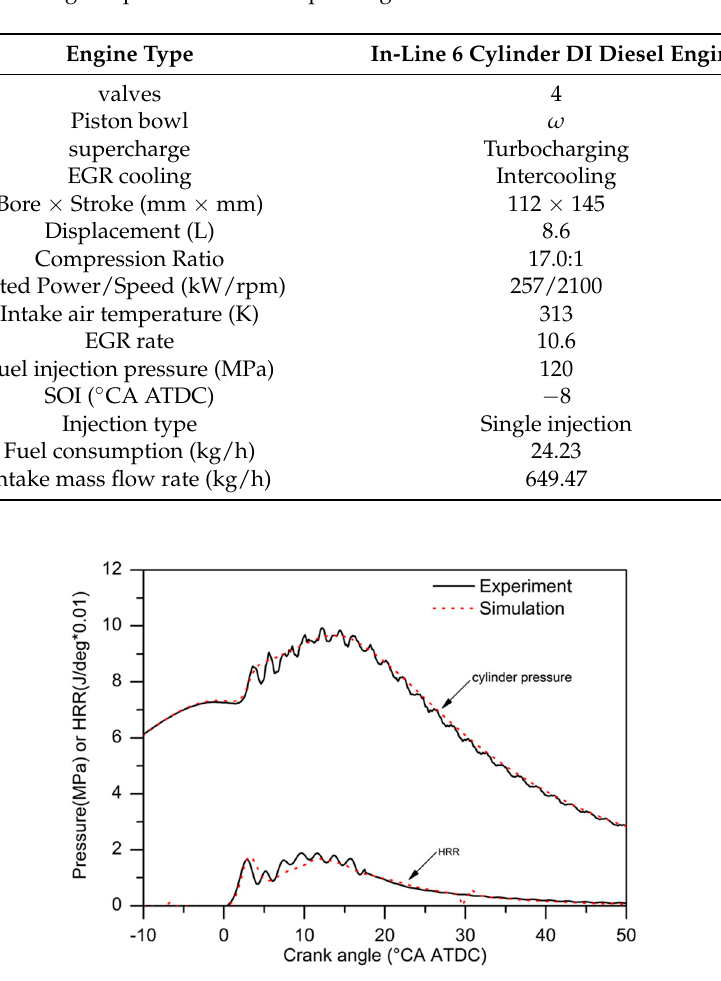
Figure 3. The test bench. Table 2. Engine specifications and operating condition for simulation validation.